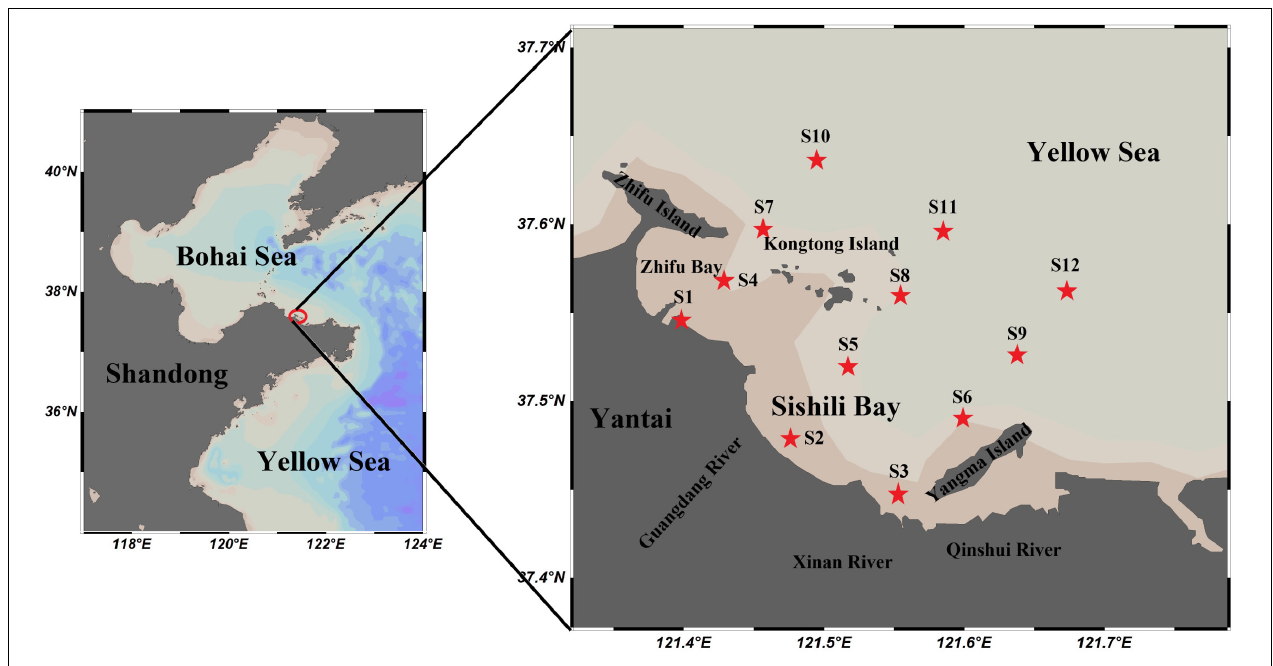
FIGURE 1 | Map of the sampling stations in Sishili Bay. The red stars mark the sampling stations.